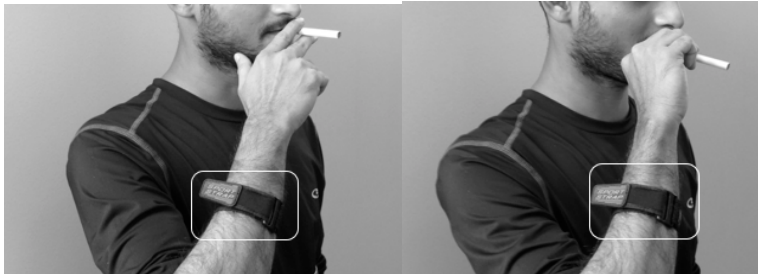
Figure 5. An instance of inertial sensor implementation on the dominant hand of smoking for detecting smoking hand gestures.